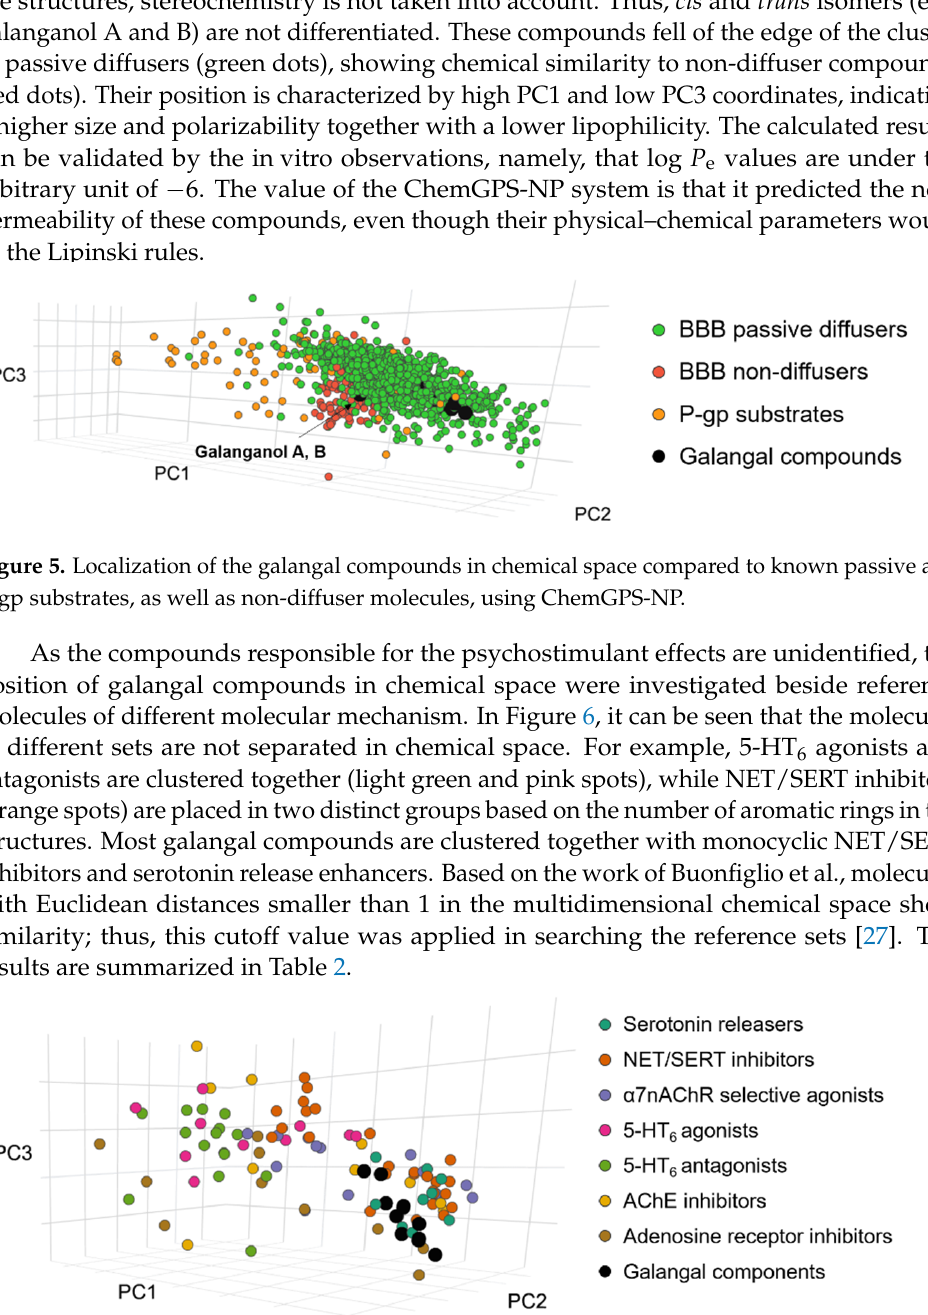
Figure 6. Localization of galanga compounds in chemical space compared to known reference molecules of different molecular mechanism. Table 2. Reference compounds and their Euclidean distances (ED) closest to galangal components. Compounds